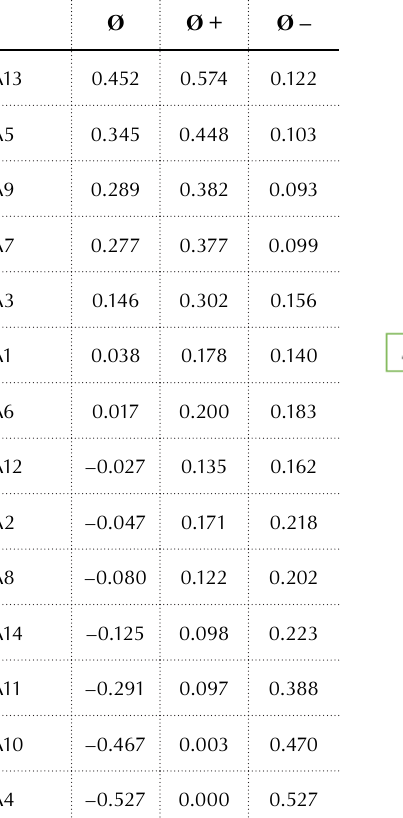
Figure 2. PROMETHEE Network